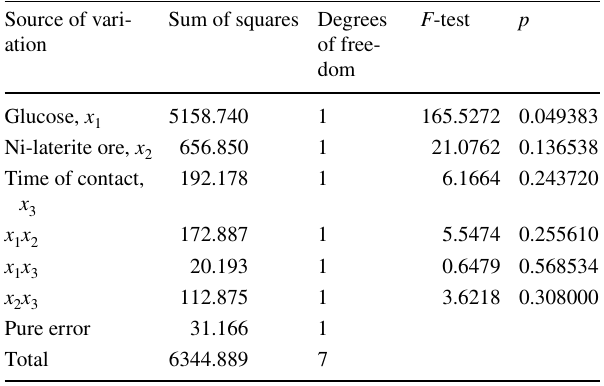
% of explained variance =